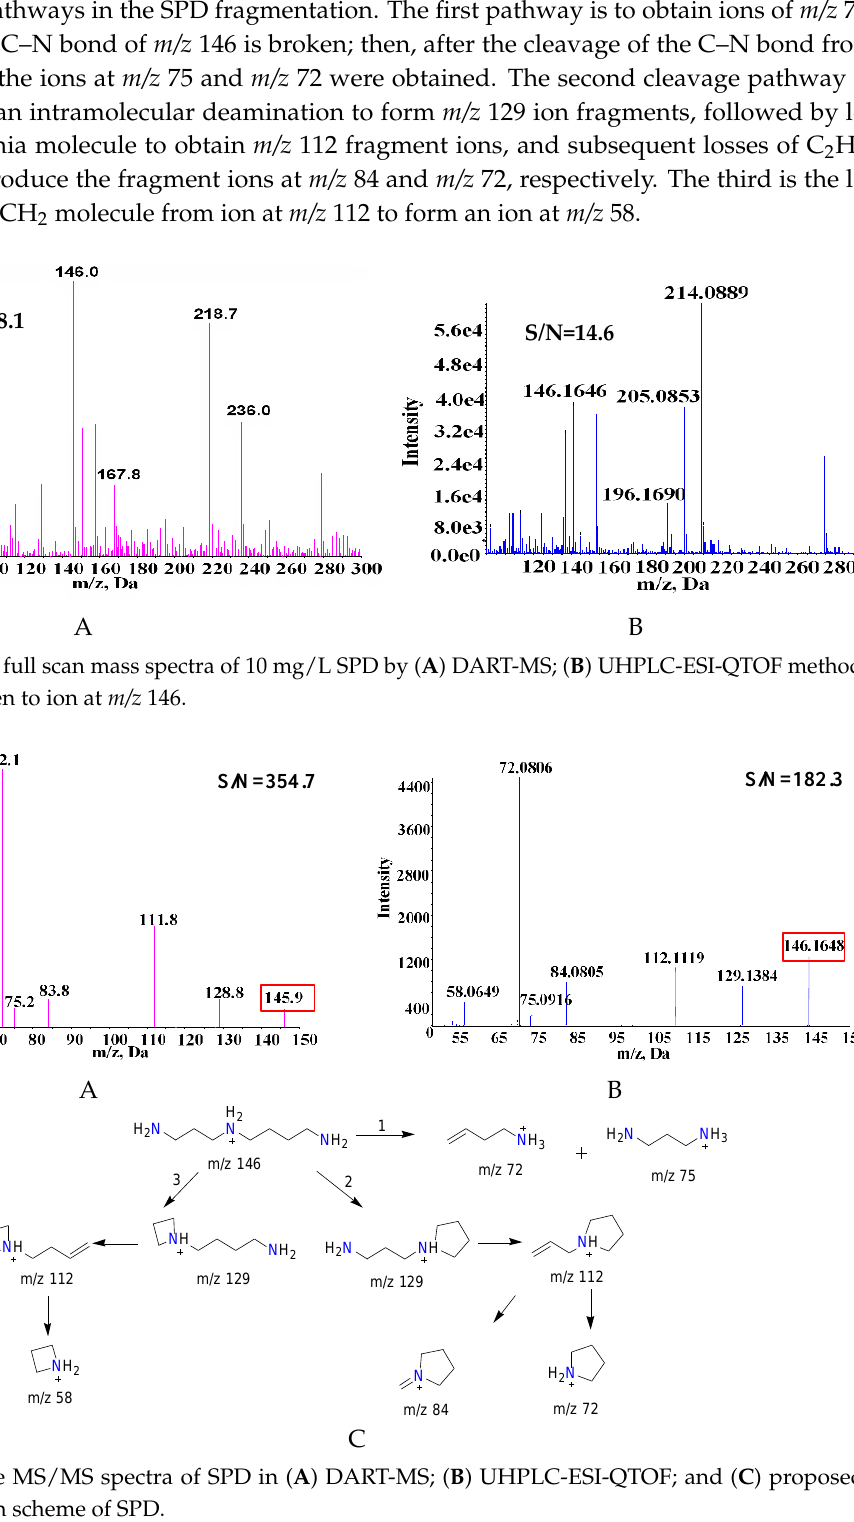
Figure 2. The MS/MS spectra of SPD in ( A ) DART-MS; ( B ) UHPLC-ESI-QTOF; and ( C ) proposed fragmentation scheme of SPD.